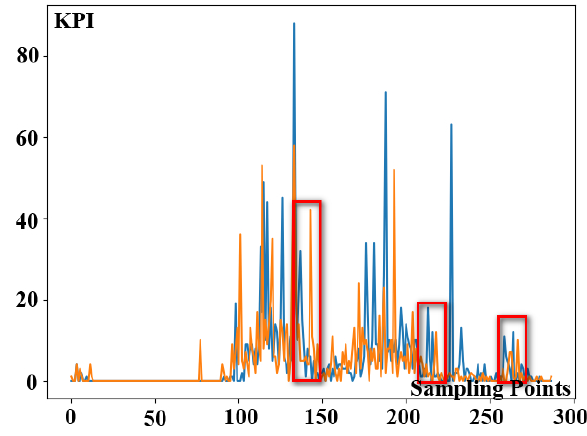
Figure 6. Cycle offset diagram of KPI time series